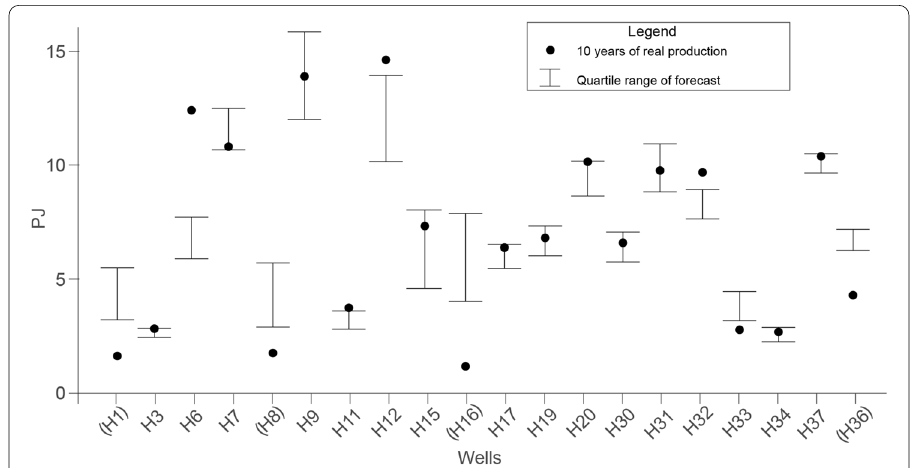
Fig. 5 Validation of the model given by Eq. (6). The observed value for the extraction is represented as a dot. Forecast using our model with 80% of the data for training is shown as a range whisker. The model is considered to be appropriate when the observed value is inside the range. Wells enclosed in parentheses operated for 22 years and they are not considered for validation as they do not have enough data